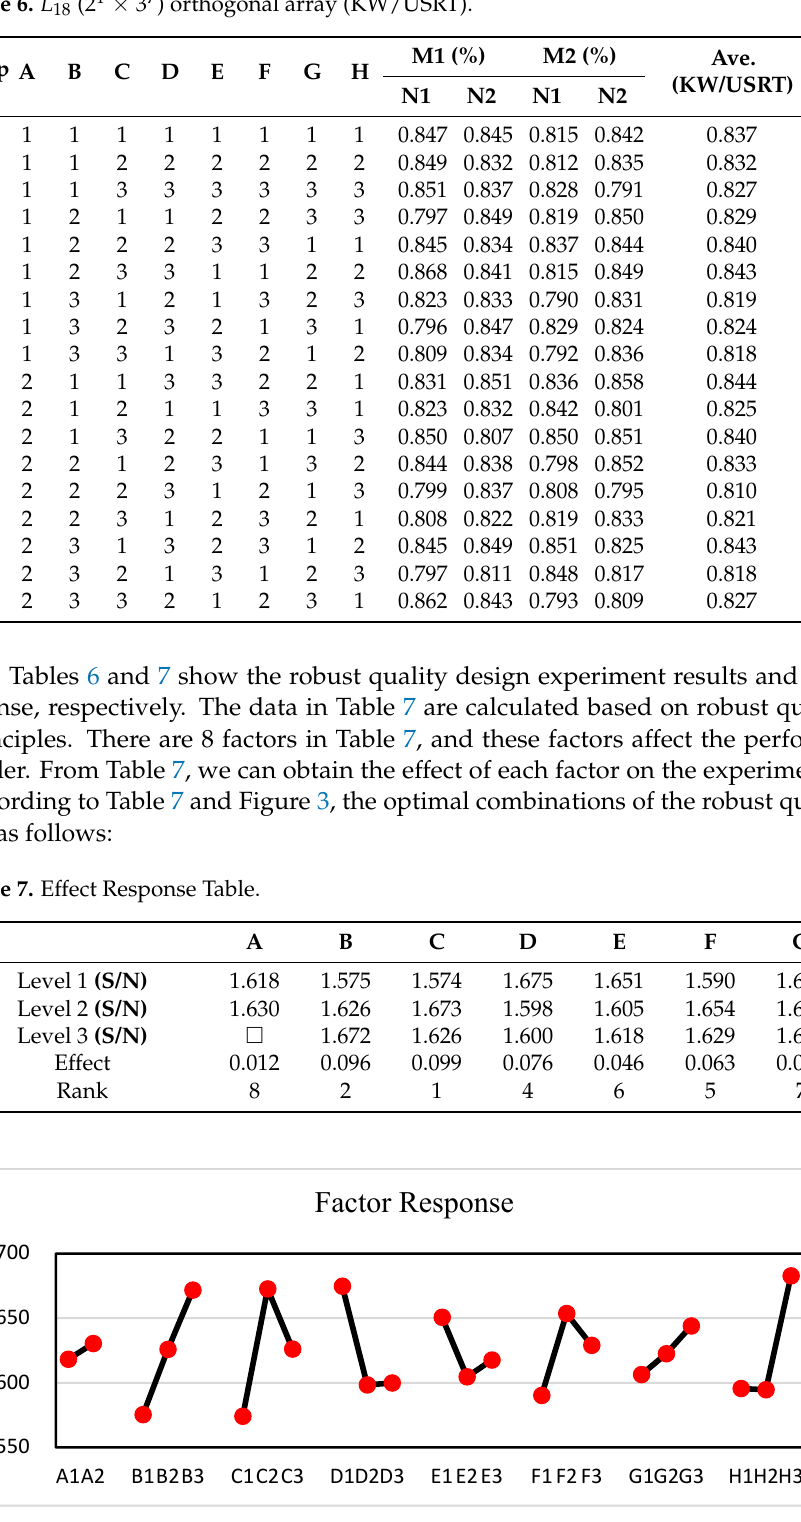
Figure 3. The Construction of Factor Response.